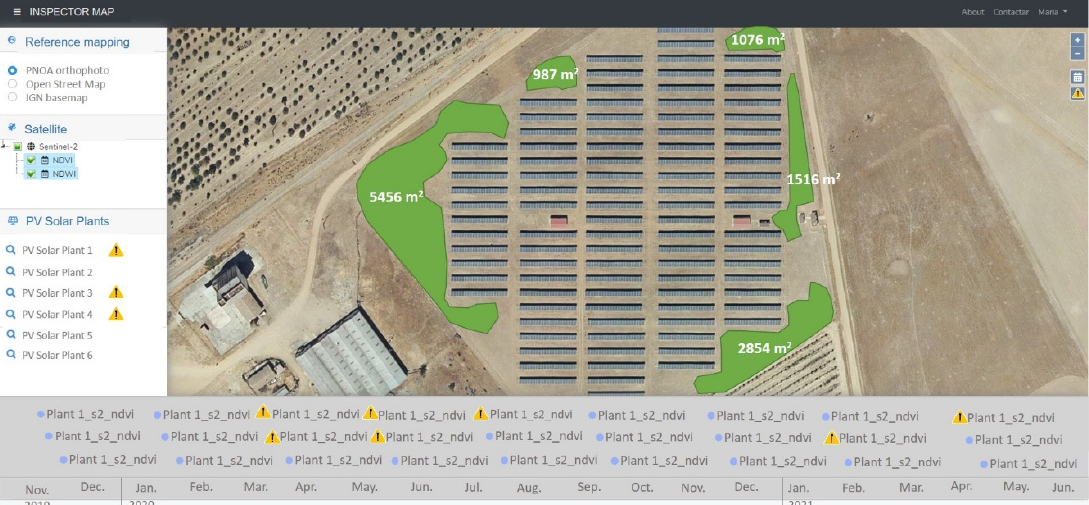
Figure 6. Visualization of results after activating the alert system in one of the photovoltaic solar plants included in the system.